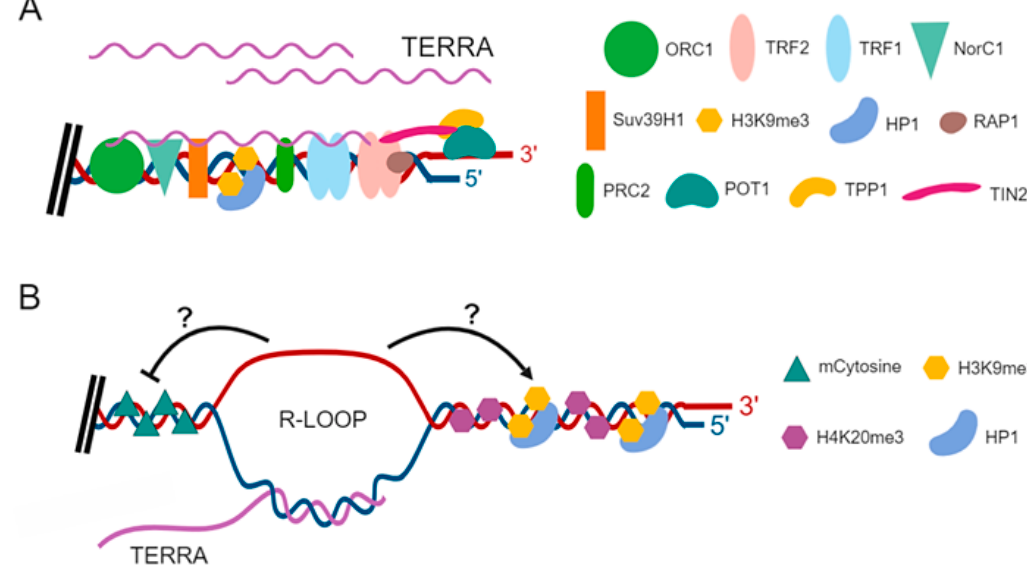
Figure 1. Proposed roles of TERRA in chromatin regulation at telomeres. ( A ) TERRA interacts with various proteins at telomeres including TRF2, Suv39h1, and origin replication complex 1 (ORC1). TERRA transcripts can act as scaffold molecules to promote the recruitment of proteins, histone modifying enzymes and chromatin remodeling complexes to chromosome ends. ( B ) TERRA forms DNA-RNA hybrid structures (R-loops) at telomeres. Telomeric R-loops can influence heterochromatin formation at telomeres by inhibiting DNA methylation or promoting the recruitment of HP1 proteins at chromosome ends.